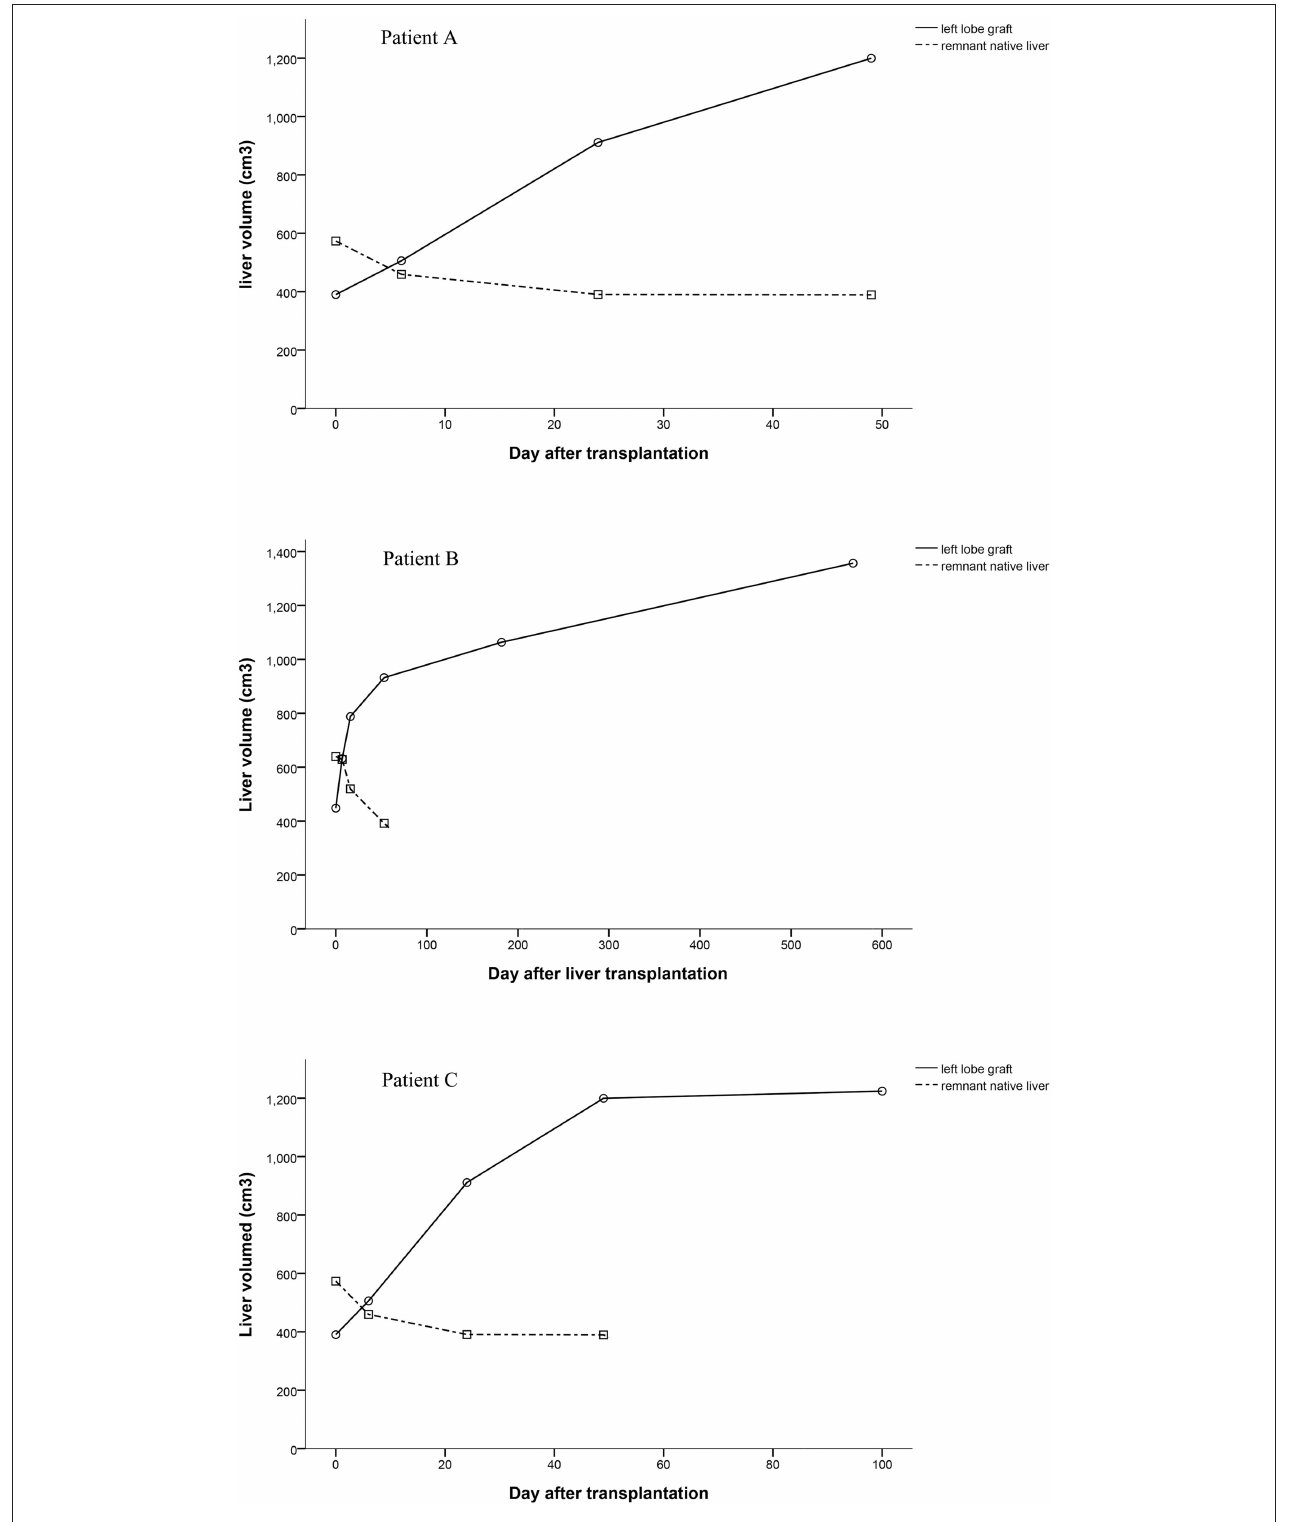
FIGURE 4 | Volume changes of the auxiliary grafts and native liver.